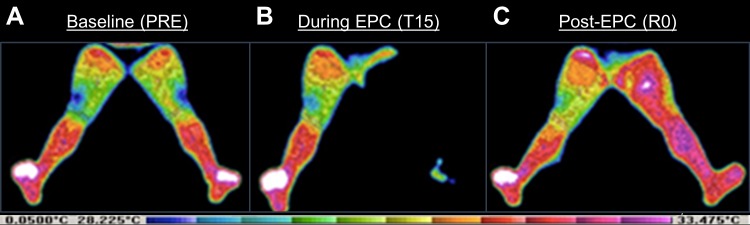
Representative thermograms.Pictured are thermograms of a participant’s lower limbs (A) after equilibration to environmental conditions (i.e., baseline [PRE]), (B) during external pneumatic compression (EPC; T15), and (C) immediately post-EPC (R0).